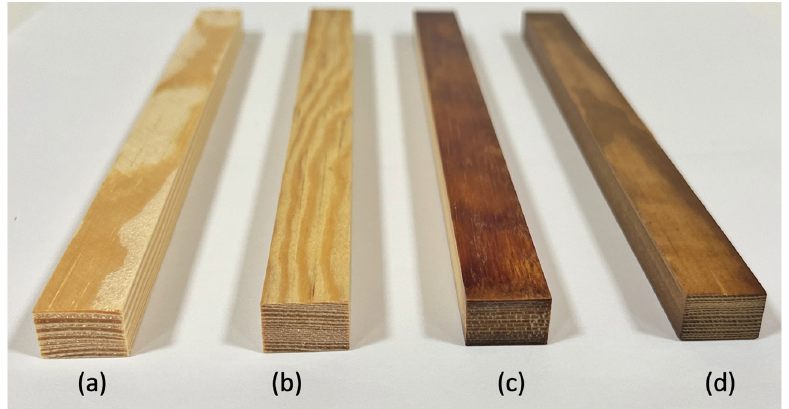
Figure 2. Specimens in the four groups: ( a ) reference without any treatment, ( b ) densified, ( c ) resin- impregnated and densified, and ( d ) densified and thereafter thermally modified. Table 1. Test groups and numbers of specimens in each group.